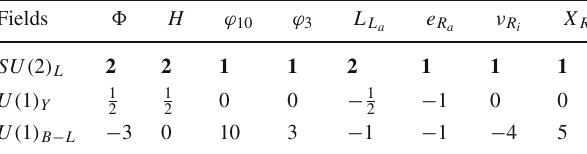
Table 1 Field contents of bosons and fermions and their charge assign- mentsunder SU ( 2 ) L × U ( 1 ) Y × U ( 1 ) B − L ,where a = 1 − 3and i = 1 , 2 are flavor indices